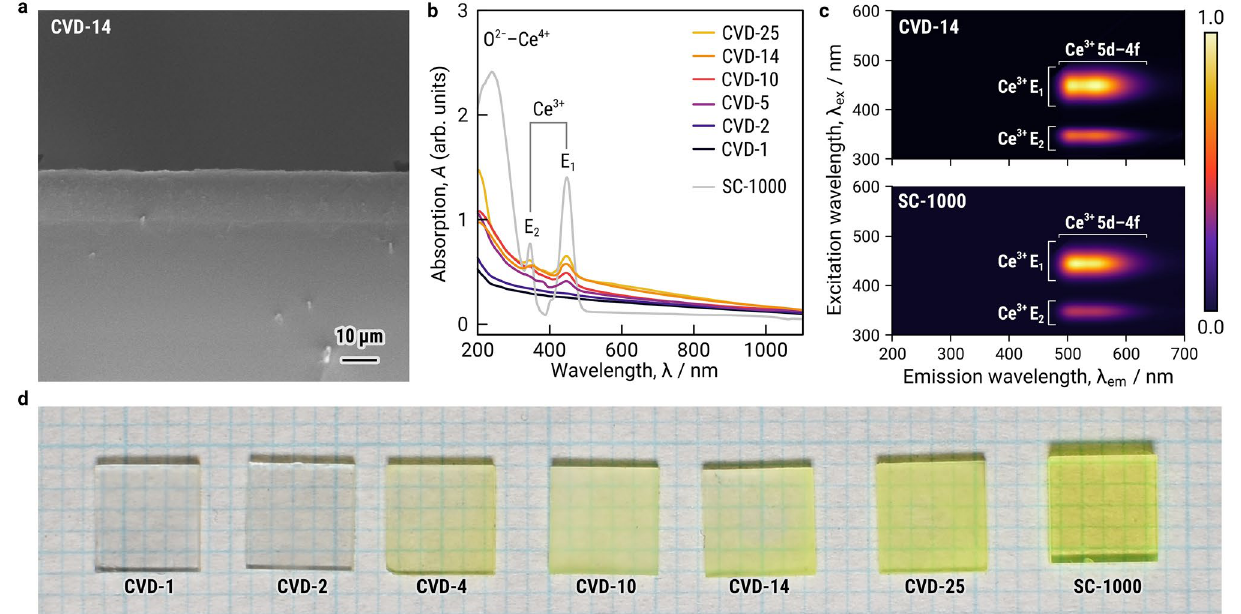
Figure 2. Characterization of CVD-Ce 3+ :LuAG thick film scintillators. ( a ) Cross-sectional SEM image of 14 μm-thick Ce 3+ :LuAG thick film scintillator grown on (100) YAG substrate (CVD-14). ( b ) Absorption spectra of the CVD-Ce 3+ :LuAG thick film scintillators with various thicknesses (CVD-1 to CVD-30) and reference Ce 3+ :LuAG single crystal (SC-1000). ( c ) Photoluminescence–excitation contour plot of CVD-20 and SC-1000. ( d ) Photographs of the Ce 3+ :LuAG thick film scintillators with various thicknesses (CVD-1 to CVD-30) and SC-1000 under room